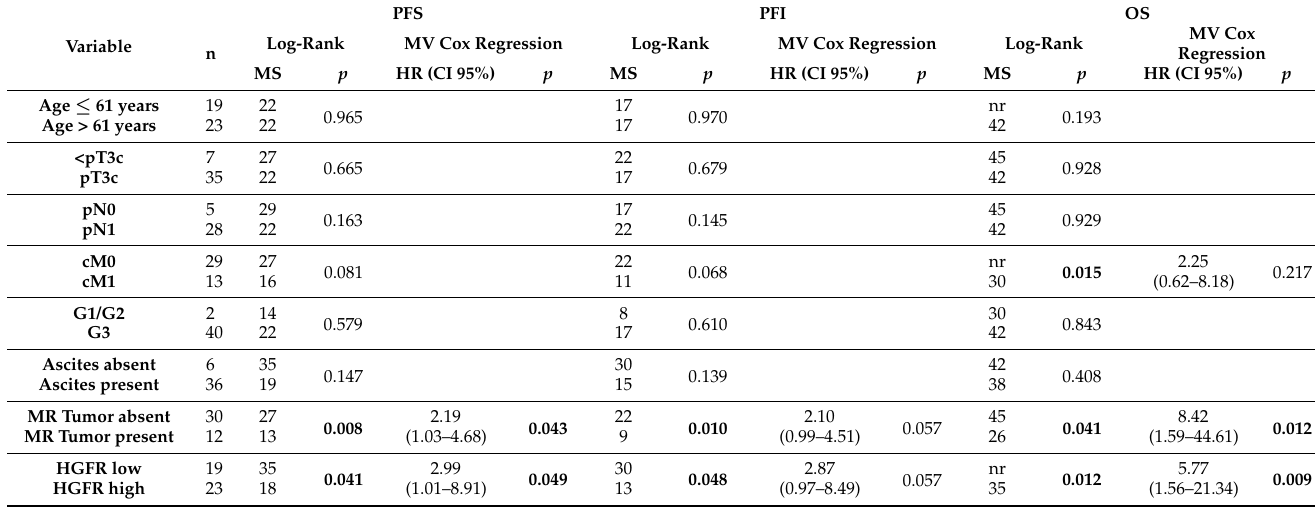
Table 3. Univariate and multivariate survival analysis of clinicopathological factors and